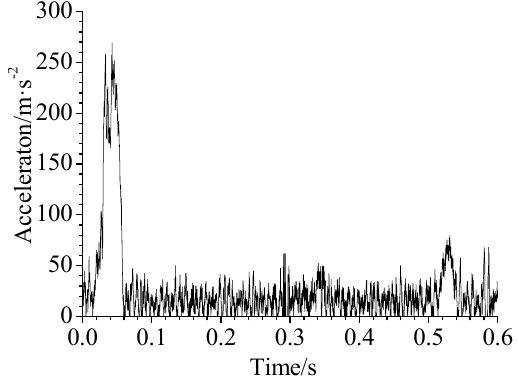
Figure 12. Record of acceleration history of impact tests.